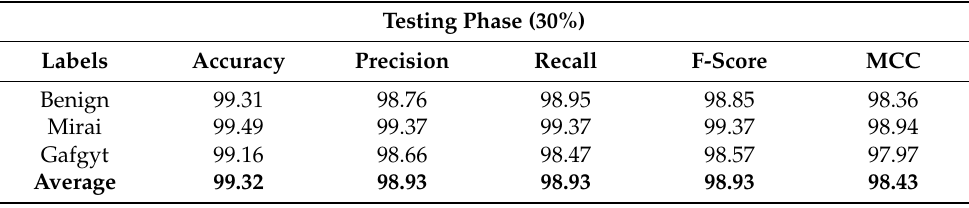
Table 4. Result analysis for BND-BMOML algorithm with distinct class labels using 30% of the TS data.